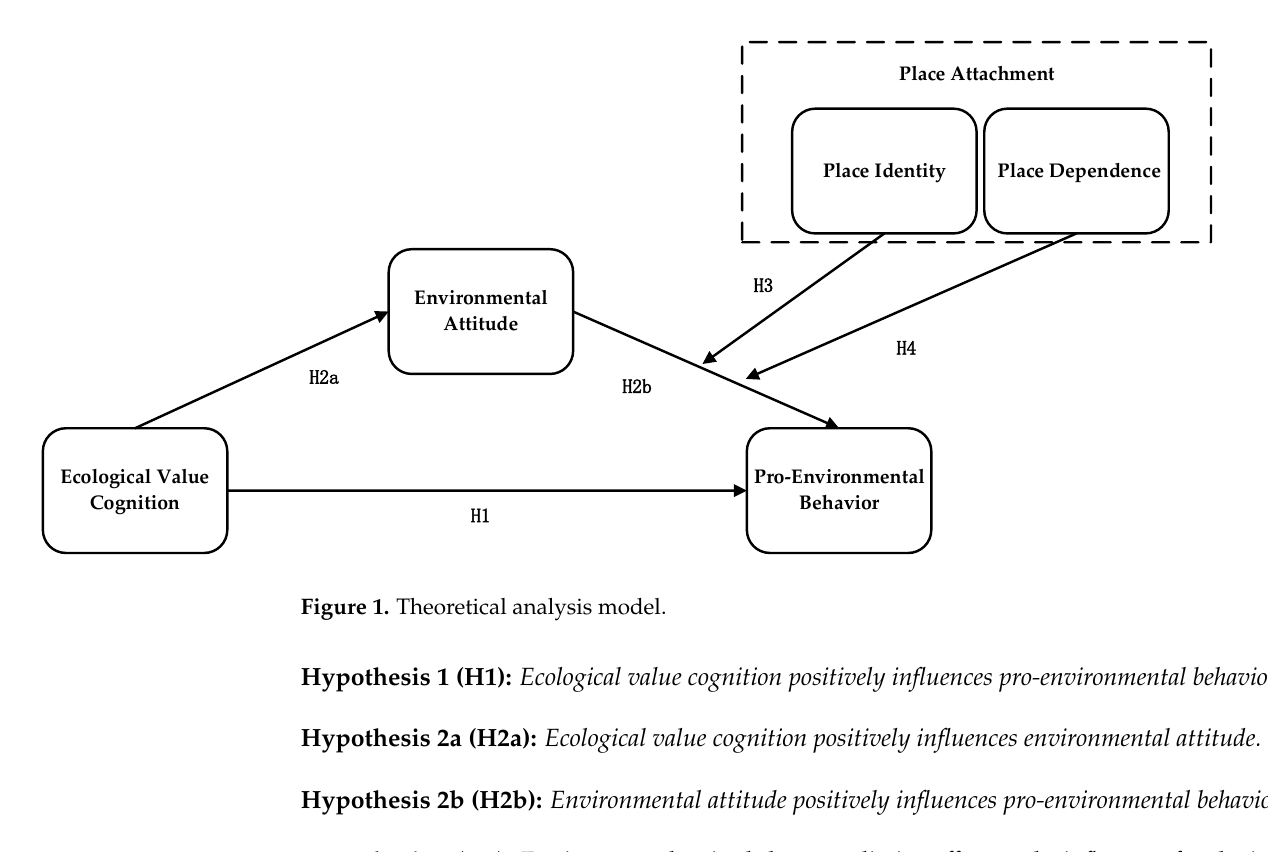
Figure 1. Theoretical analysis model.